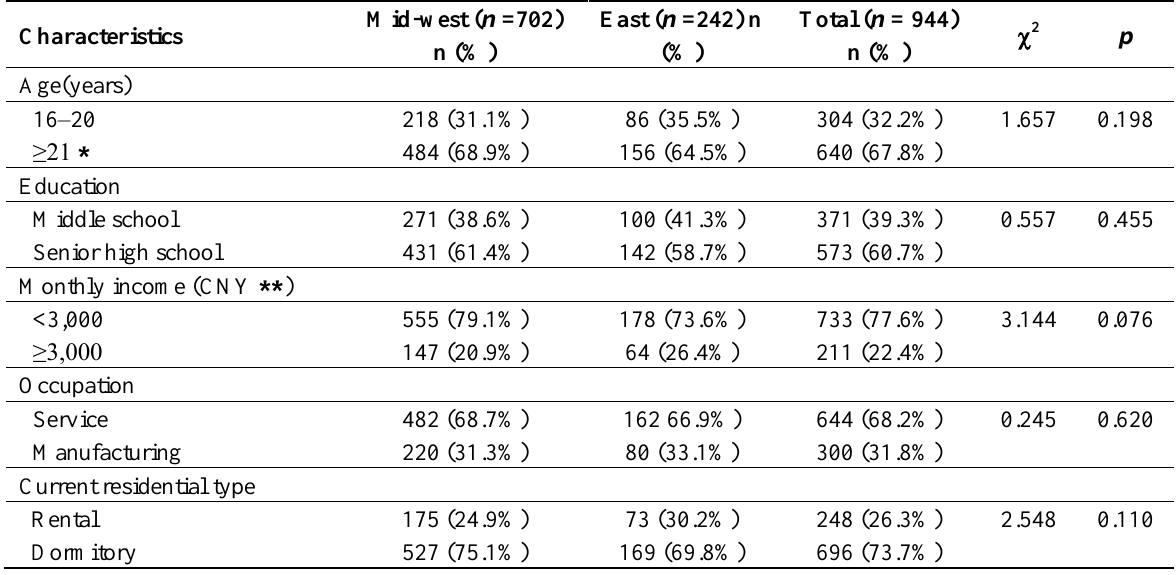
Table 1. Socio-demographic characteristics of unmarried rural-urban female migrants from mid-west and east